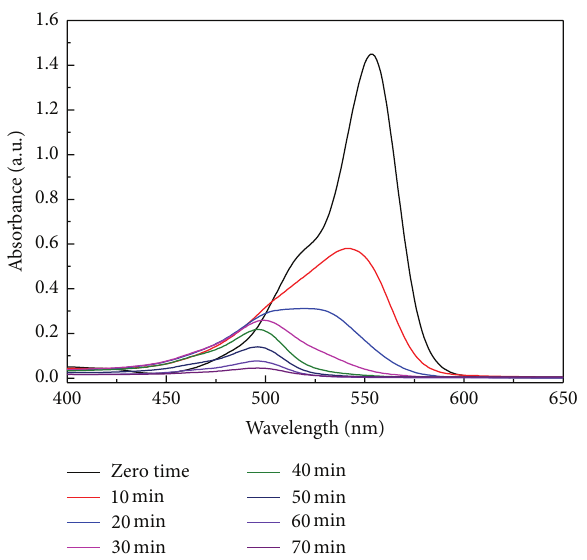
Figure 6: The absorption spectra of Rhodamine B solution over